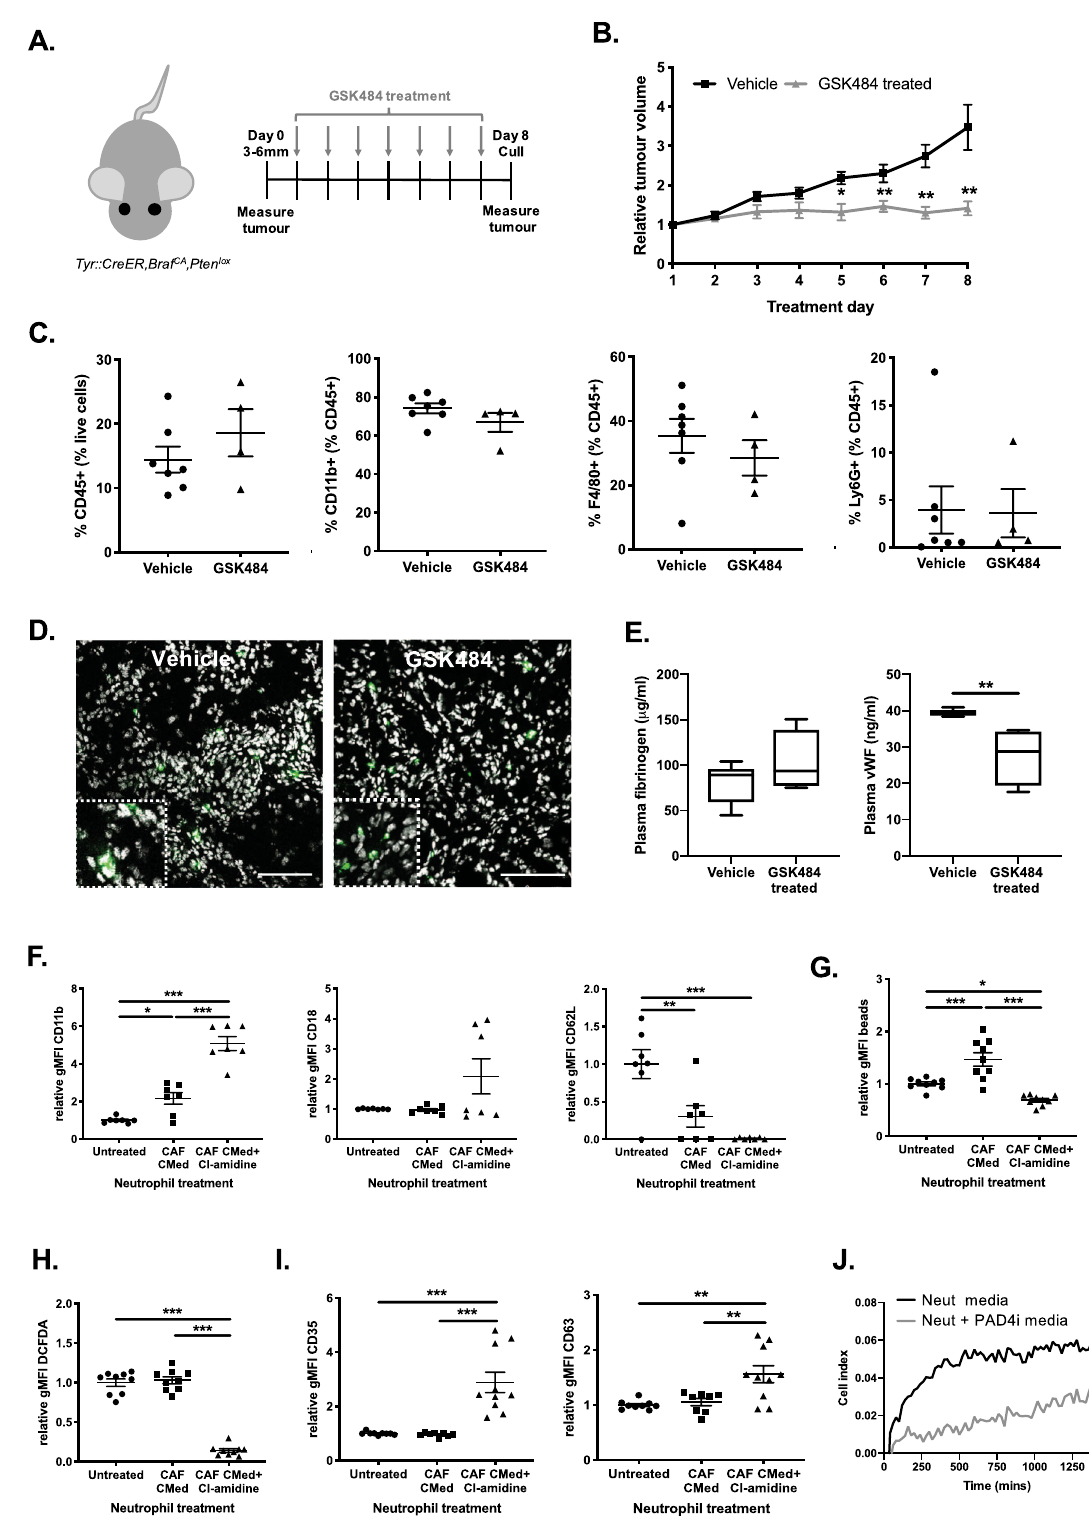
but NETs were absent (Supplementary Fig. 6C, D). Furthermore, neutrophils in tumor-bearing mice to NET, which coincided with a reduction in neutrophil death without affecting the number of neutrophils within the bone marrow (Supplementary Fig.